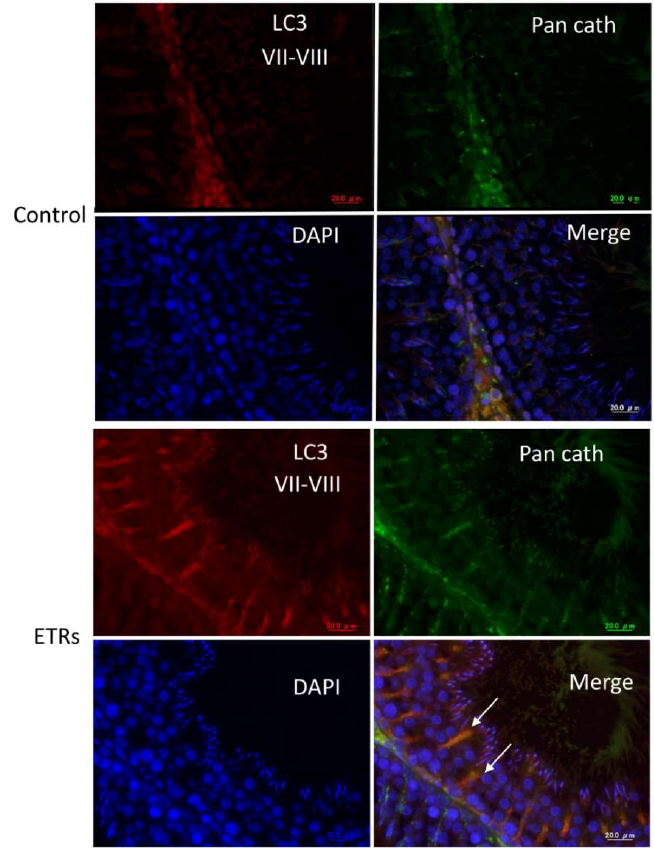
Figure 4. Immunofluorescence double-labeling for LC3 and pan cathepsin in stages VII–VIII of the spermatogenic cycle. Note the enhanced colocalization of LC3 (red) and pan cathepsin (green) in SCs of ETRs (white arrows). DAPI was used for nuclear counterstaining. Pan cath, pan cathepsin